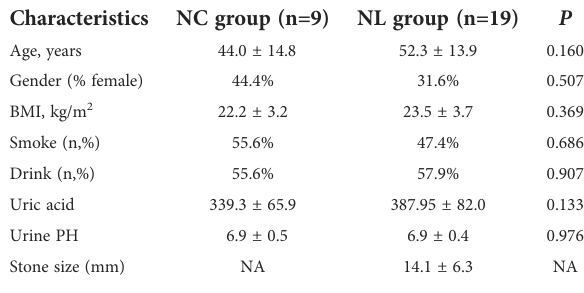
TABLE 1 Clinical information of the